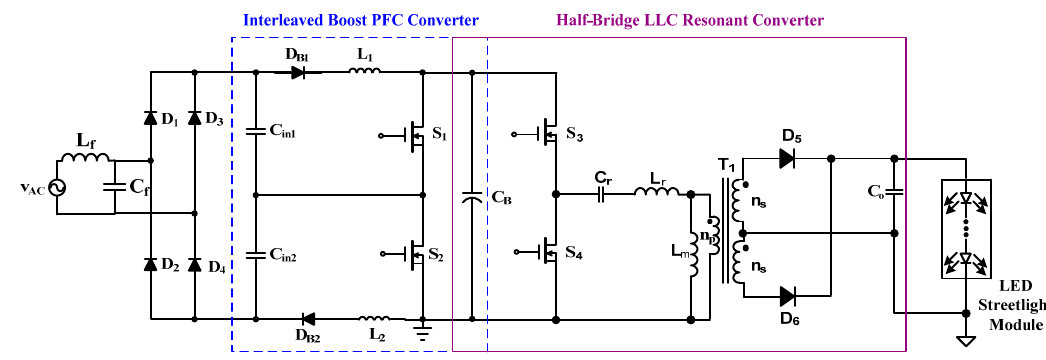
Figure 1. The conventional two-stage light-emitting diode (LED) driver for streetlighting applications, PFC: power factor